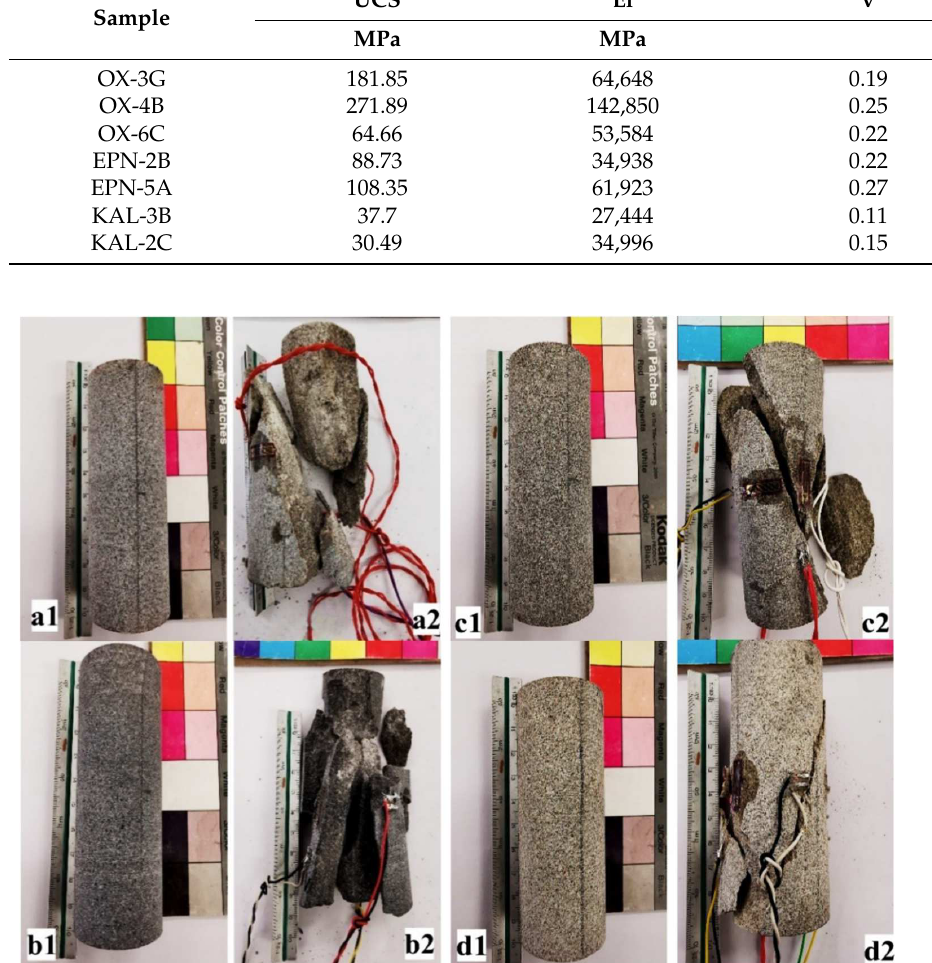
Figure 8. Typical breaks in cylindrical specimens under uniaxial compressive strength before and after the testing of the corresponding samples; ( a1 , a2 ) and ( b1 , b2 ) are from the Northern Eptachori Formation sandstones (EPN-2B and EPN-5A, respectively), ( c1 , c2 ) are from Pentalofos Formation sandstones, and ( d1 , d2 ) are from the Southern Eptachori Formation sandstones (samples: OX-3G and KAL-2C, respectively). Note the strain gauge sensors that were emplaced for the measurements in vertical and horizontal orientations.